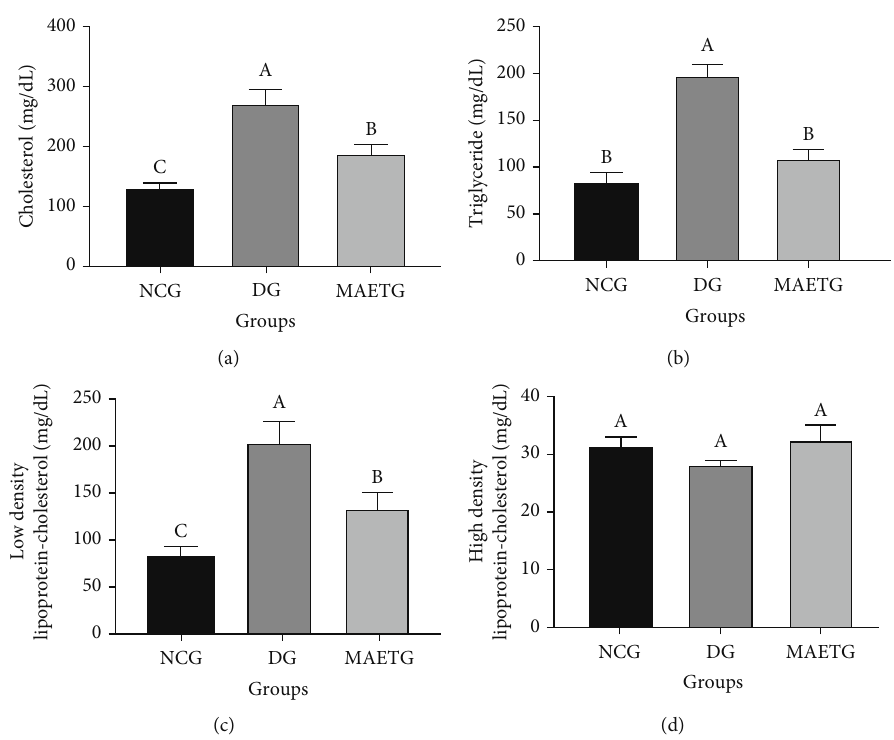
Figure 2: E ff ect of MAE on (a) total cholesterol, (b) triglyceride, (c) low-density lipoprotein cholesterol, and (d) high-density lipoprotein cholesterol in STZ-induced diabetic rats after 30 days of treatment. Data were presented as mean ± SD . Data were analyzed using ANOVA followed by LSD. The mean di ff erence is signi fi cant at p < 0 : 05 . Di ff erent superscript letters (A, B, and C) denote signi fi cance while similar letters denote no signi fi cance between groups. Each group contained 10 rats. Table 4: E ff ect of MAE of C. myrrha on serum glucose, fasting insulin, HbA1C, and HOMA-IR index in STZ-induced diabetic rats after 30 days of treatment.